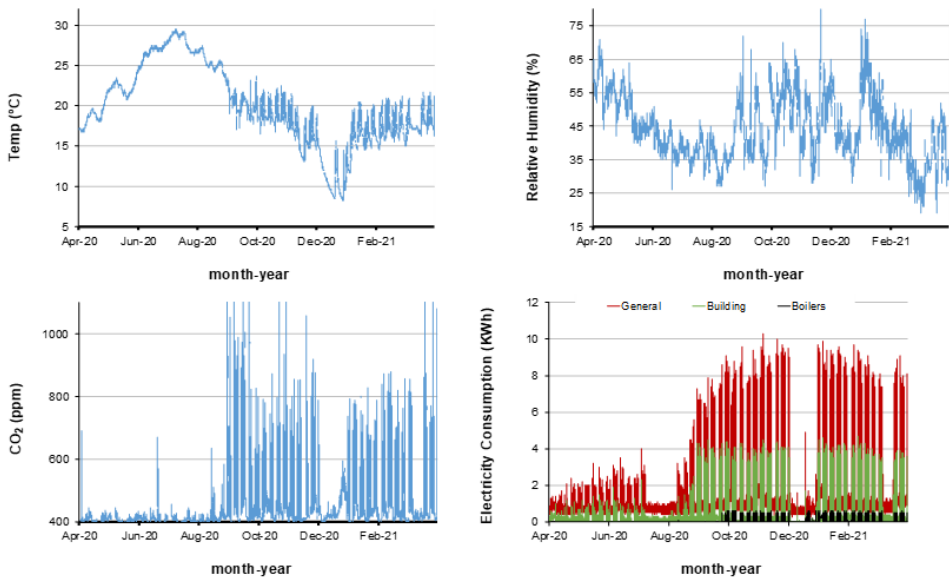
Figure 3. Overview of the typical annual behavior of different variables assessed as possible indicators of occupancy status in schools.